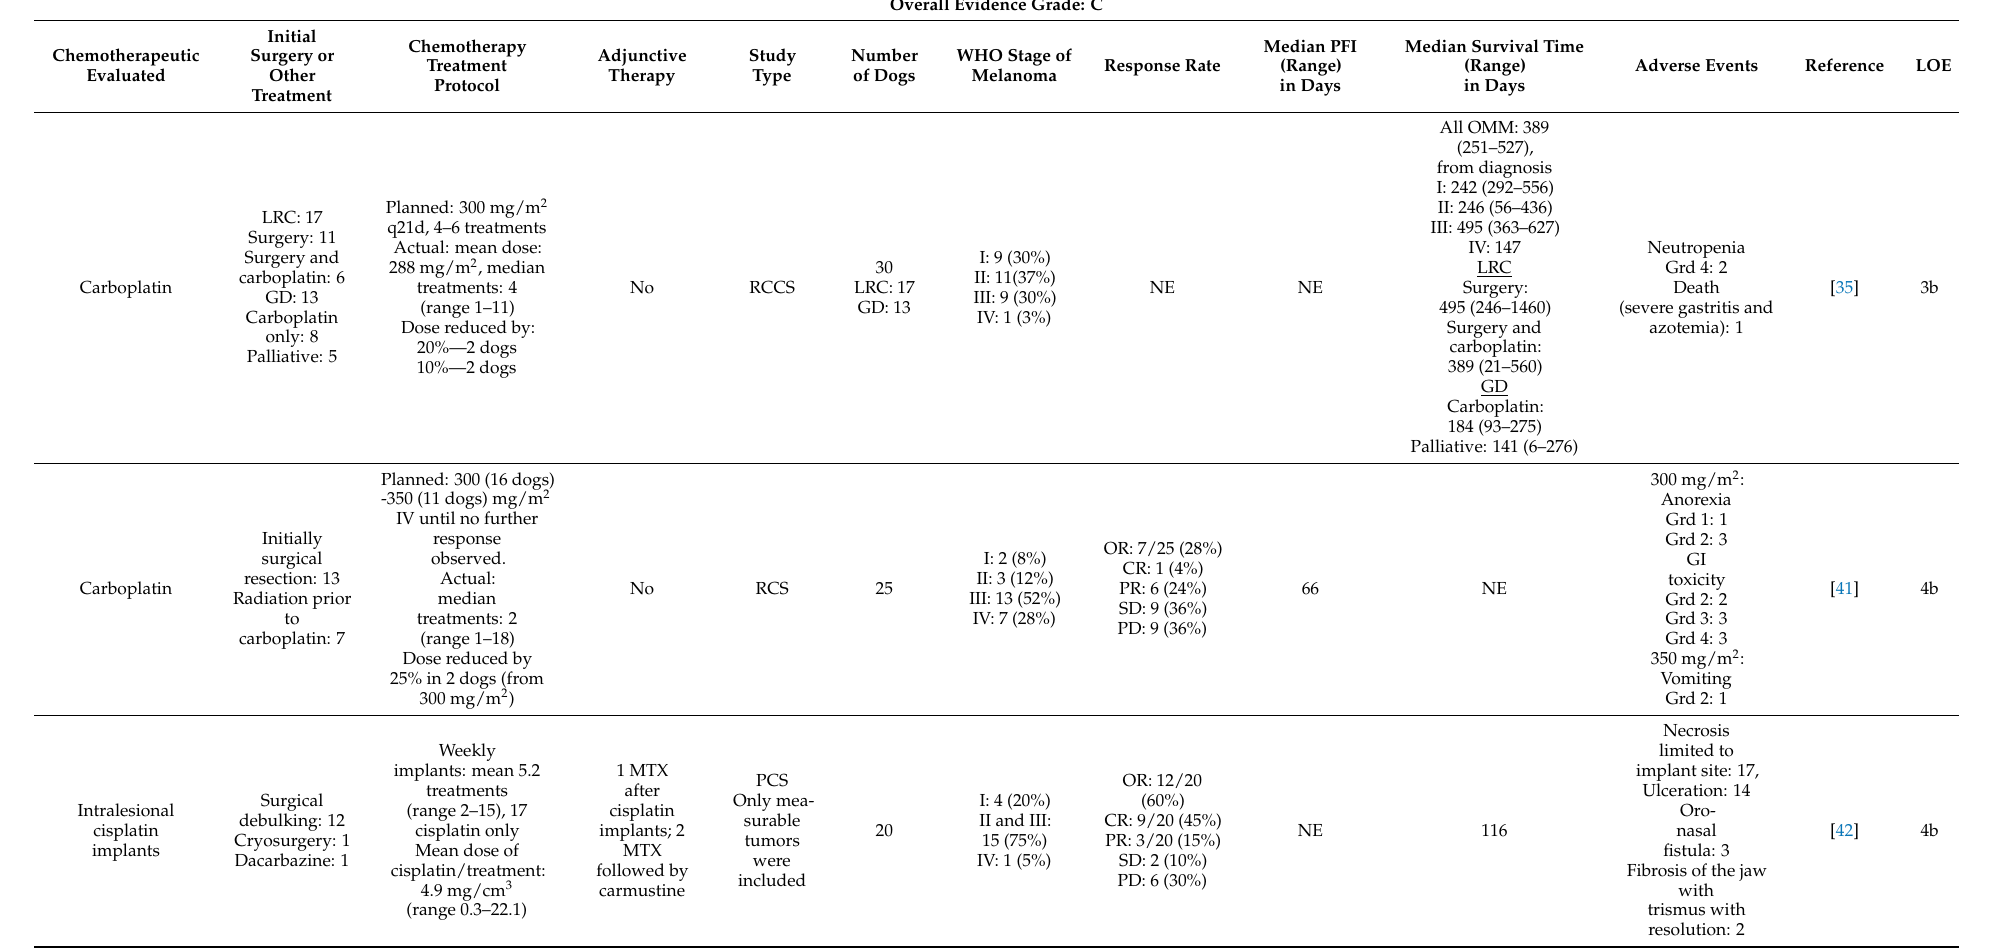
Table 3. Summary of chemotherapeutic studies evaluating effectivity in oral malignant melanoma. Overall Evidence Grade: